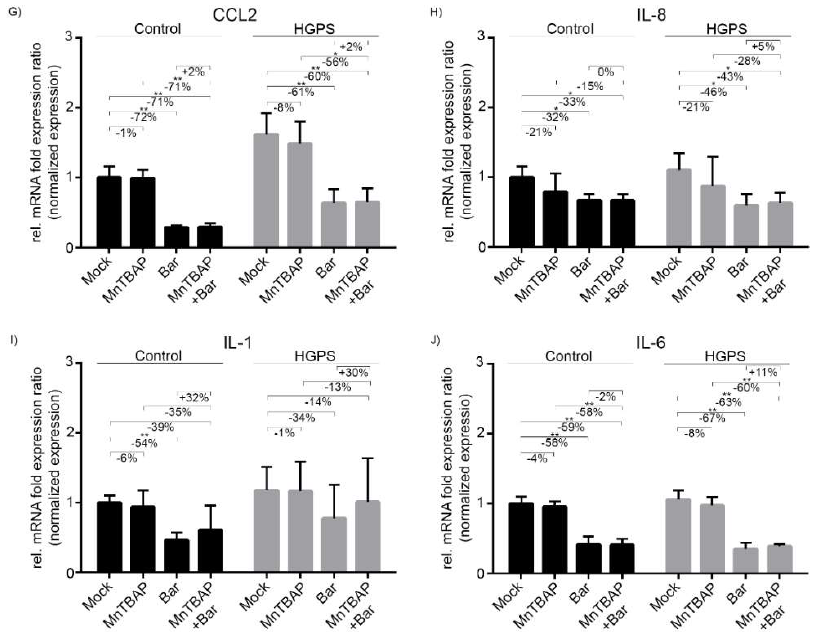
Figure 2. MnTBAP/Bar treatment reduces inflammation. ( A , B ) Representative Western blots detect- ing STAT1, P-STAT1, STAT3, and P-STAT3, normalized to β -actin. The control and HGPS fibroblasts were treated for 9 d with a mock solution, 5 µ M MnTBAP, 1 µ M Bar, or the MnTBAP/Bar combination. ( C ) Quantification of STAT1, ( D ) STAT3, ( E ) P-STAT1, and ( F ) P-STAT3 signals. Relative mRNA levels of CCL2 ( G ), IL-8 ( H ), IL-1 ( I ), and IL-6 ( J ). Relative expression was normalized to that of GAPDH. Graphs show the mean ± SD ( n = 3; * p < 0.05, ** p < 0.01, *** p < 0.001).